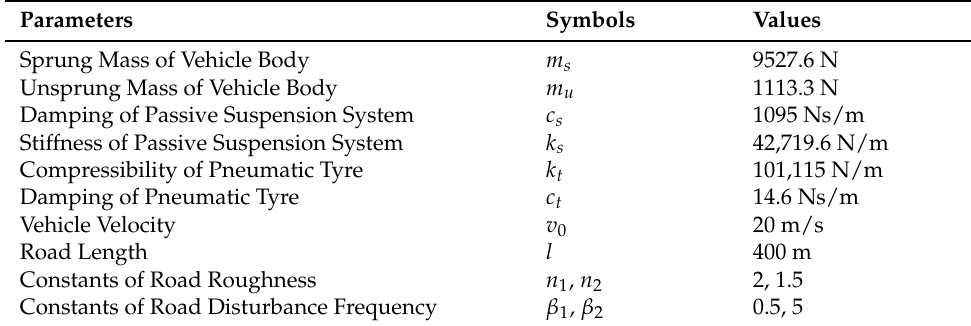
Figure 2. The curve of irregular road disturbances. Table 1. Parameters of vehicle active suspension and road